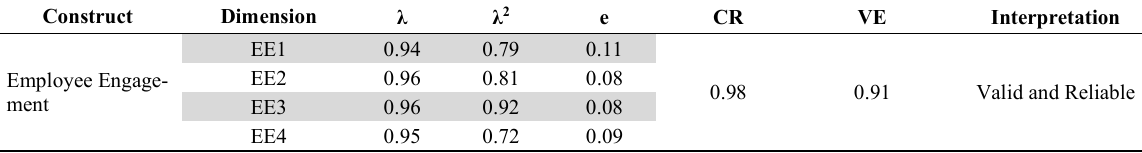
Validity and Reliability Tests on Employee Engagement Construct